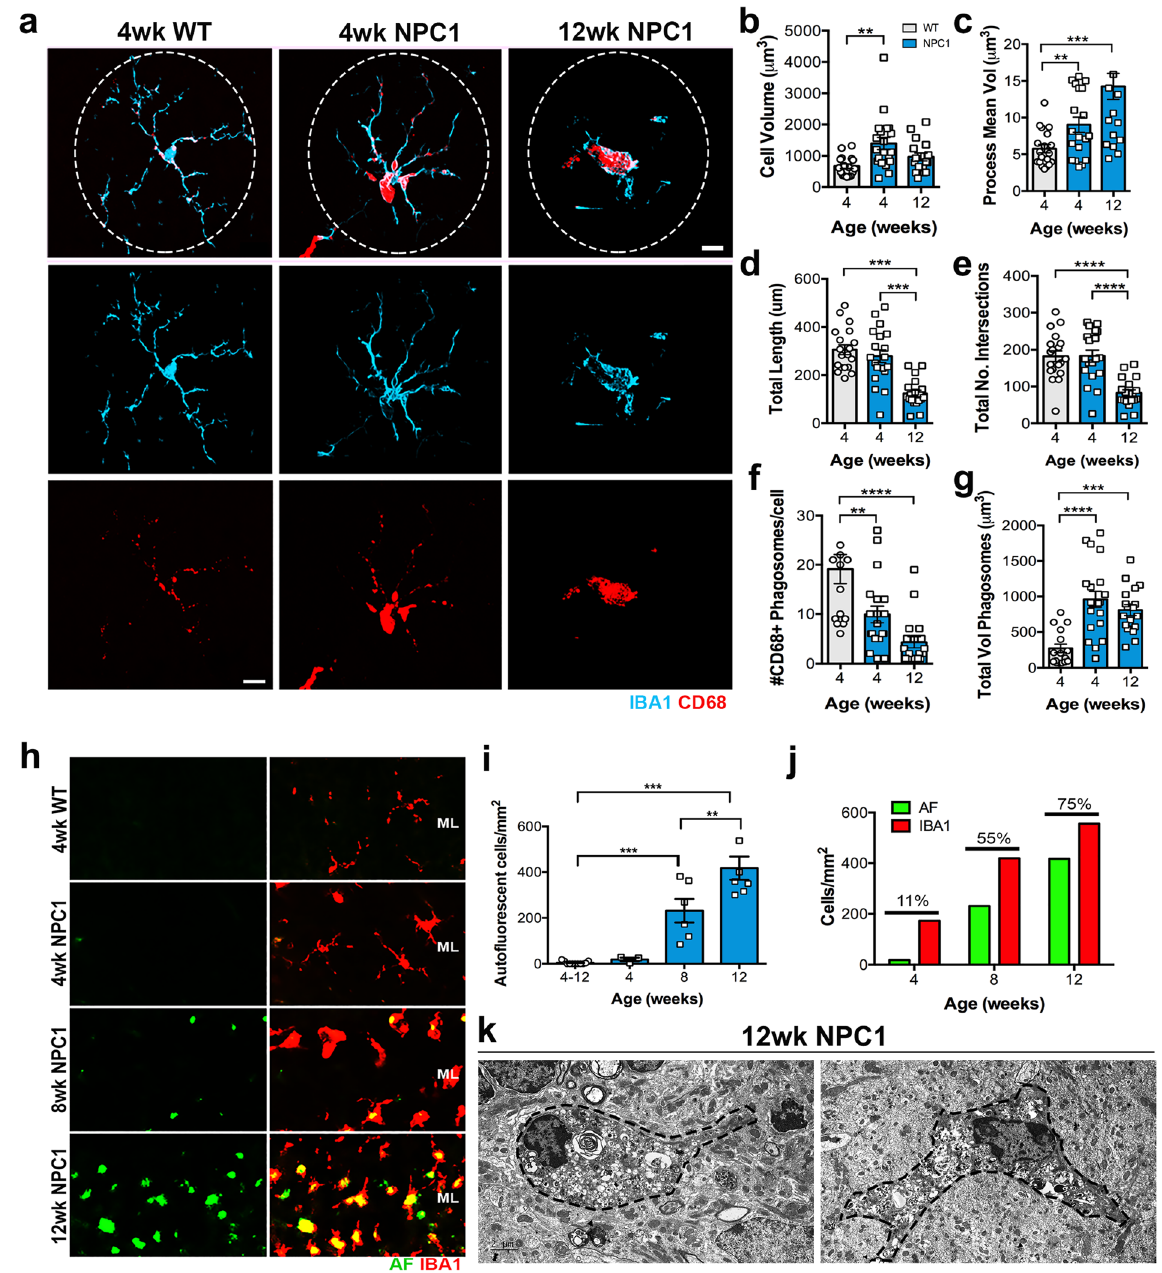
Figure 3. Morphological changes and accumulation of phagosomes in Npc1 nmf164 IBA1 + microglia. ( a ) IBA1 (cyan) and CD68 (red) immunolabeled microglia from 4 and 12 weeks old Npc1 nmf164 mice